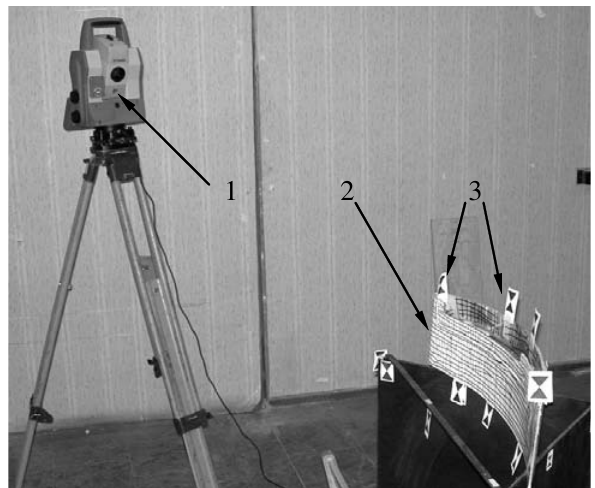
Fig 1. Layout of measuring equipment for experiment: 1 – tacheometer, 2 – tested wing section, 3 – marks